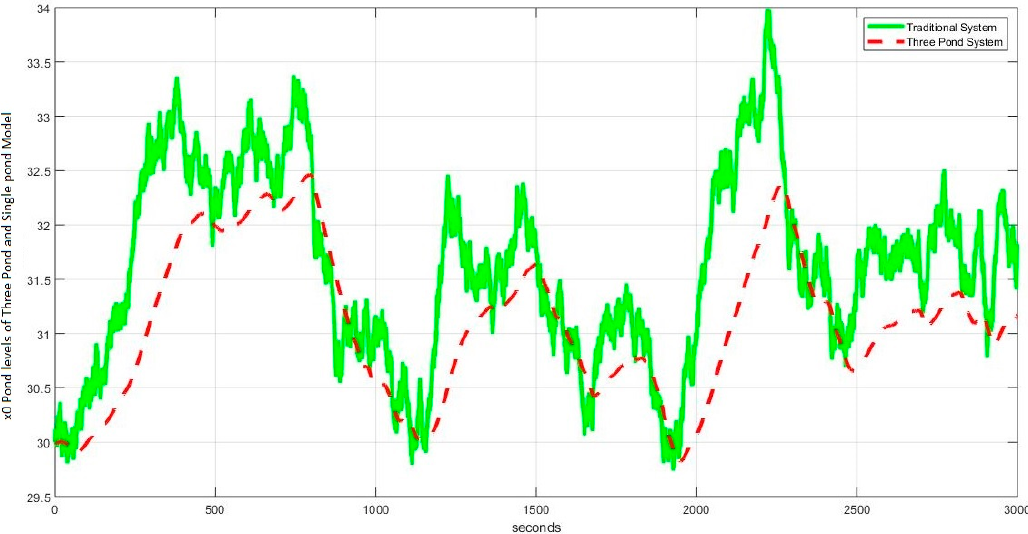
Figure 23. Comparison between the proposed system (half) and traditional system (white noise disturbance).